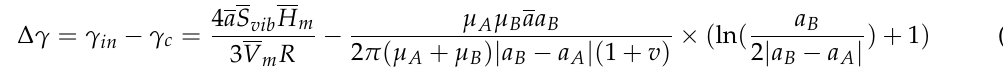
Figure 4. Stability diagram plotting g  as a function of  [22].